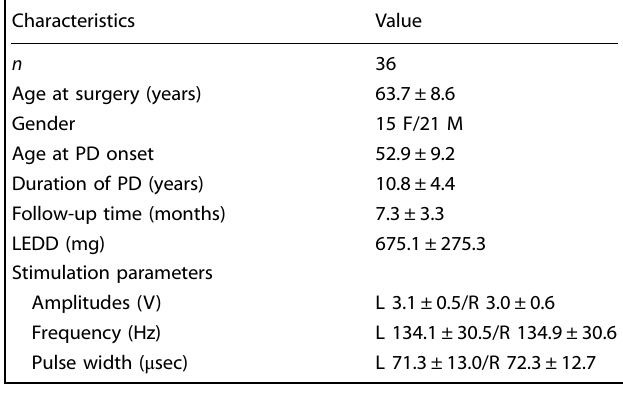
Table 1. Characteristics of included patients.